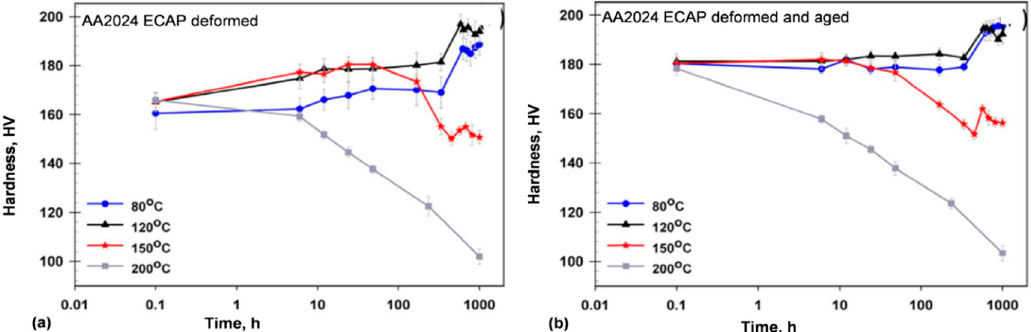
Figure 19. Thermal stability of nanocrystalline AA2024 alloy deformed by Equal Channel Angular Pressing (ECAP): ( a ) heated in as-deformed state; ( b ) heated after deformation and peak aging for 1 h at 190 °C [73].